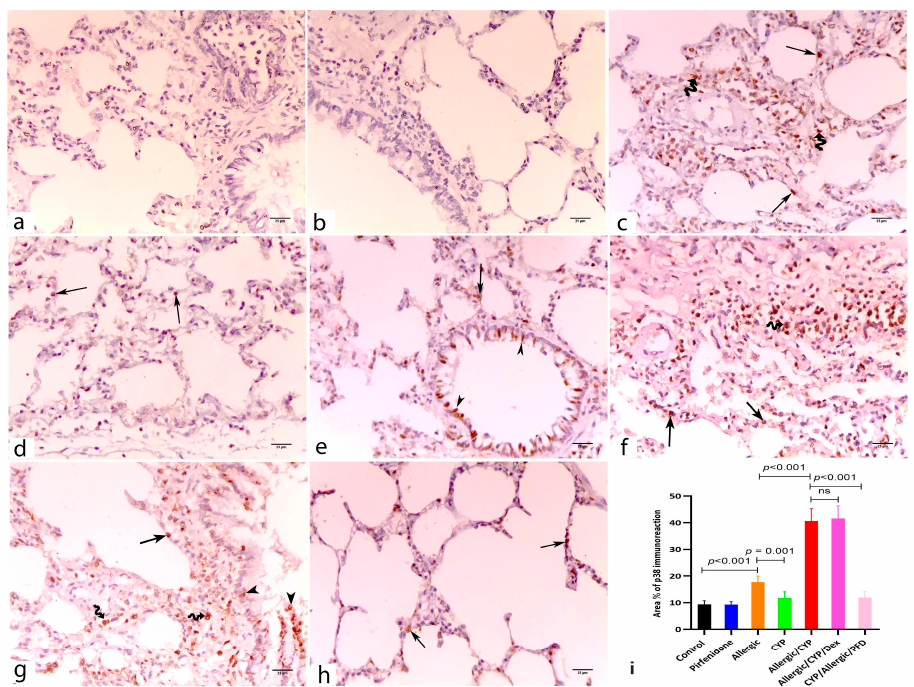
Figure 5. Anti-p38MAPK immunoassay lung sections of the study groups. ( a , b ) control and PFD alone-treated groups, respectively, show negative immunoreaction. ( c ) Allergic pneumonitis group shows p38 positive alveolar lining cells (arrow) and interstitial macrophages (zigzag arrows). ( d ) CYP-exposed group shows few p38 positive alveolar cells (arrows). ( e , f ) Allergic/CYP-exposed group shows extensive distribution of p38 immunopositivity staining the alveolar (arrows), bronchial lining cells (arrowheads), and interstitial macrophages. ( g ) Allergic/CYP/Dex-treated group shows the persistence of the p38 +ve alveolar (arrows) and bronchial cells (arrowheads), in addition to macrophages (zigzag arrow). ( h ) Allergic/CYP/PFD-treated group shows very few positive alveolar cells (arrows). ( i ) Representative figure of the mean area percentage of p38 immunopositivity among the study groups at the end of the experiment, n = 5. The significant difference and the p -value